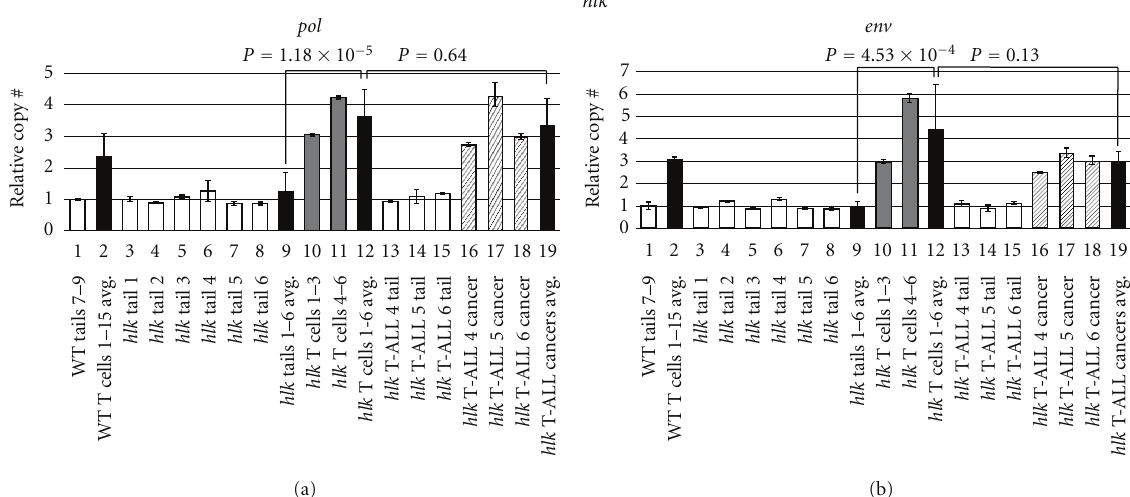
Figure 4: ZFERV amplifications in hlk zebrafish. DNA from 6 hlk fish with normal phenotype and 3 with GFP + cancers was tested by qPCR of pol (a) and env (b). White bars show tail DNA of individual normal (lanes 3–8) or T-ALL + (lanes 13–15) fish. All were statistically similar to each other and to WT Tails 7–9 (lane 1). Pooled T cells from hlk fish without T-ALL (gray bars) had ZFERV gains comparable to normal WIK T cells (lane 2). Mean copy number was higher in hlk T cells than tails (lane 9 versus 12) in the same animals. Diagonally striped bars show amplifications in neoplastic T cells of 3 hlk fish (lanes 16–18). Mean copy gains were similar in non-malignant and malignant hlk T cells (lane 12 versus 19). Other details are as described in the legend to Figure